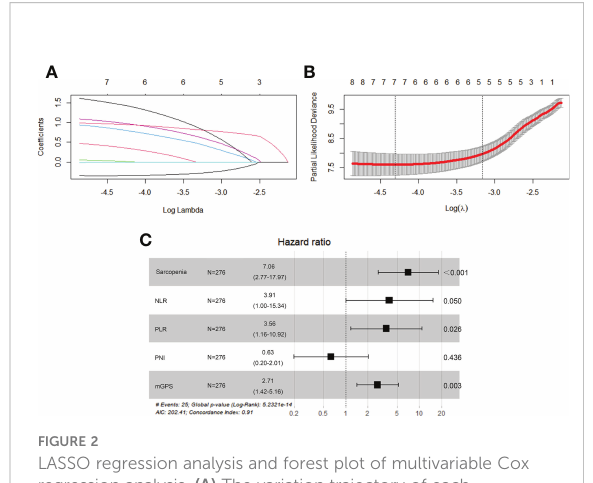
FIGURE 2 LASSO regression analysis and forest plot of multivariable Cox regression analysis. (A) The variation trajectory of each independent variable. The logarithm of the independent variable lambda was taken as the horizontal axis, and the coef fi cient of the independent variable was taken as the vertical axis. (B) Con fi dence intervals for each phase for each lambda, the vertical black dotted lines de fi ned the optimal values of lambda, which provides the best fi t. (C) Independent predictors screened by multivariable Cox regression analysis and presented as forest plot. NLR, neutrophil-to-lymphocyte ratio; PLR, platelet-to- lymphocyte ratio; PNI, prognostic nutritional index; mGPS, modi fi ed Glasgow Prognostic Score.